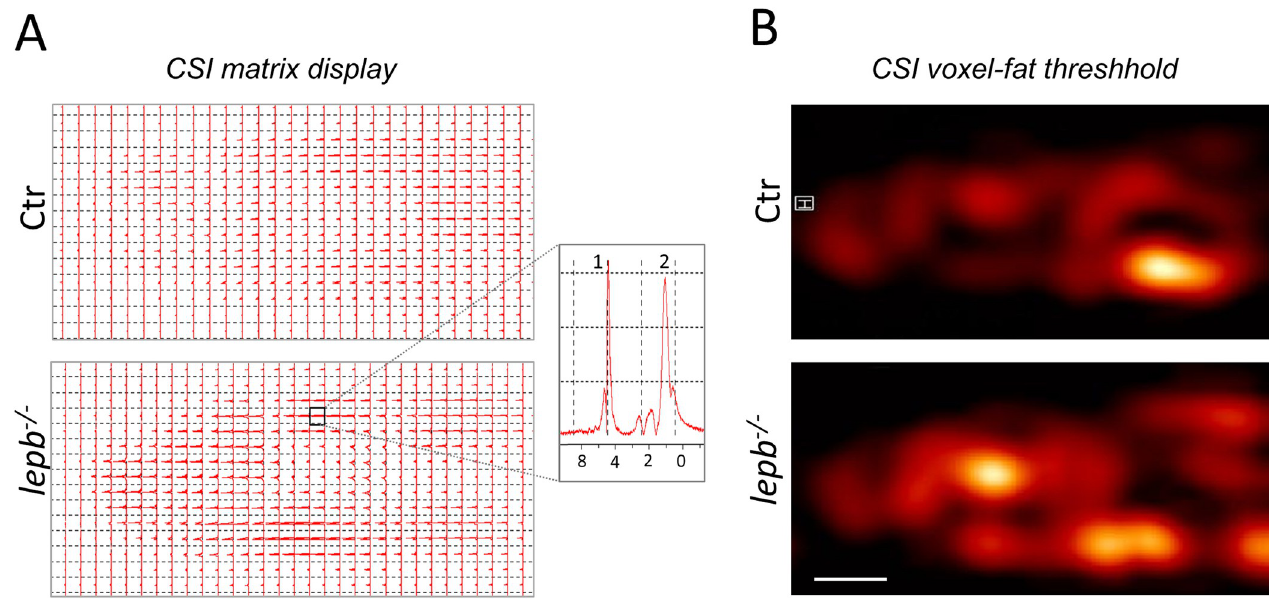
Fig 2. Chemical shift imaging. (A) Matrix display of chemical shift imaging spectra. CSI data was recorded with a TR = 3500 ms; TE = 15 ms and slice thickness was 2 mm. Total averages were 256. The resolution obtained was 1.25 × 1.25 × 2mm 3 . The spectral width used was 10 kHz (13.33 ppm) and 32x32 matrix was reconstructed into 64 × 64 voxels. Inset: Representative spectra of a single voxel showing residual water (1) and fat resonances (2). The main– (CH 2 ) n − signal in muscles is centered around 1.3 ppm, with side lobes from–(CH 2 ) n –CH 3 up-field and -CH 2 -CH = CH-,–CH 2 –CH 2 –COOR extending downfield. (B) CSI voxel intensity thresholding. Signals between 0.80 to 1.25 ppm corresponding to fat were chosen to reconstruct CSI images and they were overlaid with corresponding T 2 -weighted RARE images using the Bruker CSI Visualisation Tool. Scale bar: 1 mm.